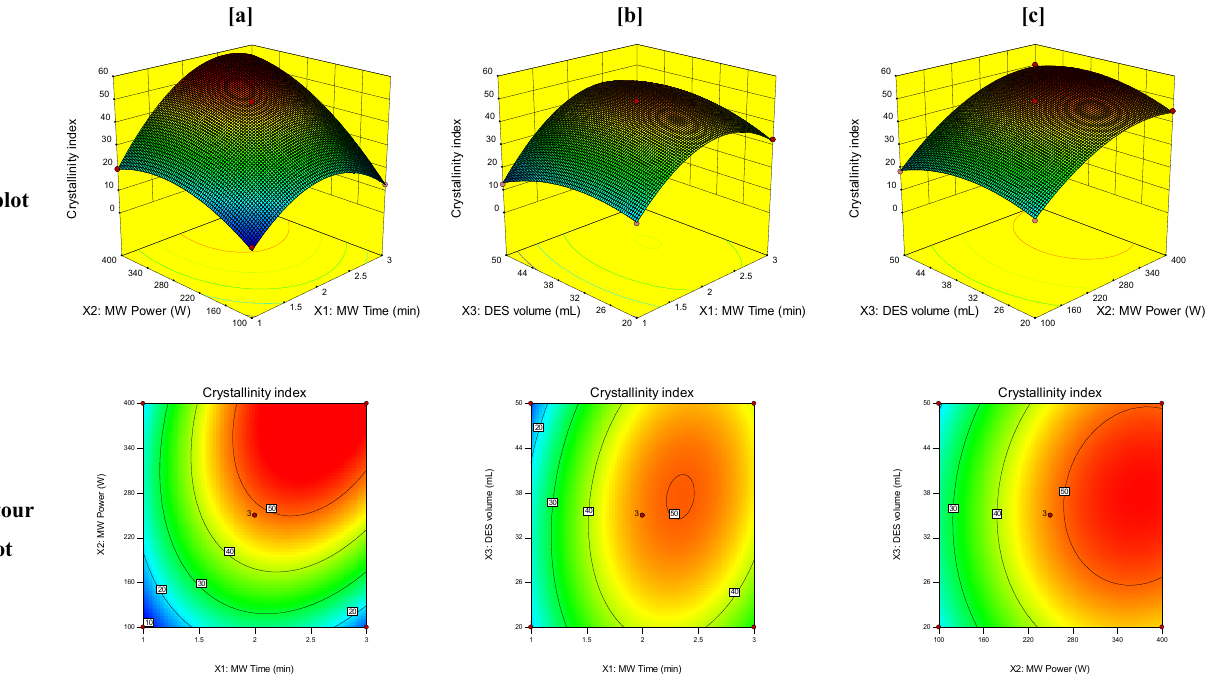
Figure 3. 3D and contour plots of the effect of the interaction of ( a ) MW time (X 1 ) and MW power (X 2 ), ( b ) MW time (X 1 ) and volume of DES (X 3 ), and ( c ) MW power (X 2 ) and volume of DES (X 3 ) on the crystallinity index.